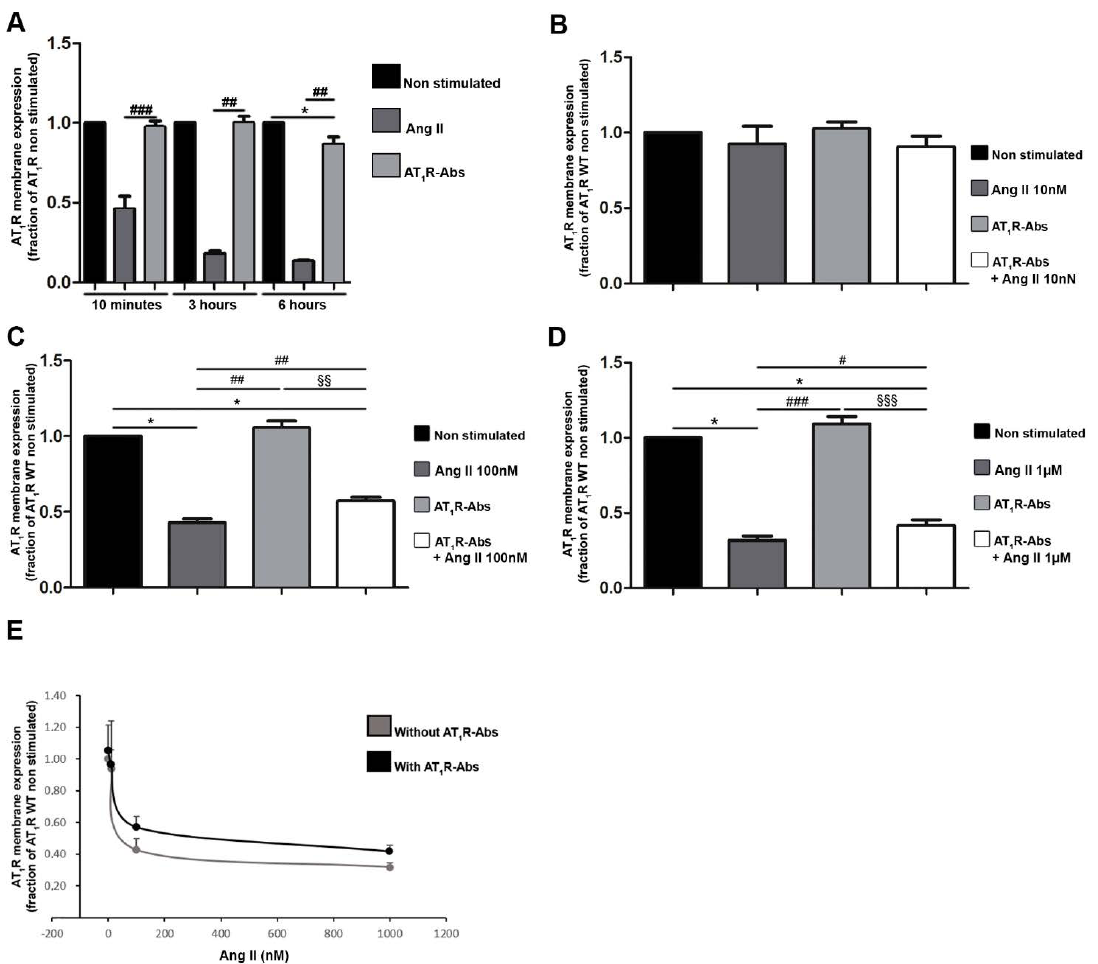
Figure 2. Angiotensin II (Ang II) type 1 receptor auto-antibodies (AT 1 R-Abs)-induced reduction in Ang II-mediated internalization of AT 1 R. ( A ) Human Embryonic Kidney293T cells ( HEK293T) transfected to express a HiBiT-tagged AT 1 R were incubated for 10 min, three or six hours with 1µM Ang II or 1mg/mL AT 1 R-Abs. ( B – D ) Ang II stimulation in HEK293T dose-dependently triggered a decrease in AT 1 R expression at the plasma membrane. Cells transfected with the HiBiT-tagged receptor were pre-incubated with or without 1mg/mL AT 1 R-Abs for six hours before stimulation with increasing concentrations of Ang II for 10 min. Results are gathered in ( E ). SEMs derived from 7 to 14 experiments ( A – D ) are shown along with p -values for Wilcoxon or Mann–Whitney tests. (* p < 0.05 as compared with HiBiT-AT 1 R WT without stimulation; # p <0.05, ## p < 0.01, ### p < 0.001 as compared with HiBiT-AT 1 R WT stimulated with Ang II; §§ p < 0.01, §§§ p < 0.001 as compared with AT 1 R WT pre-incubated with AT 1 R-Abs.)